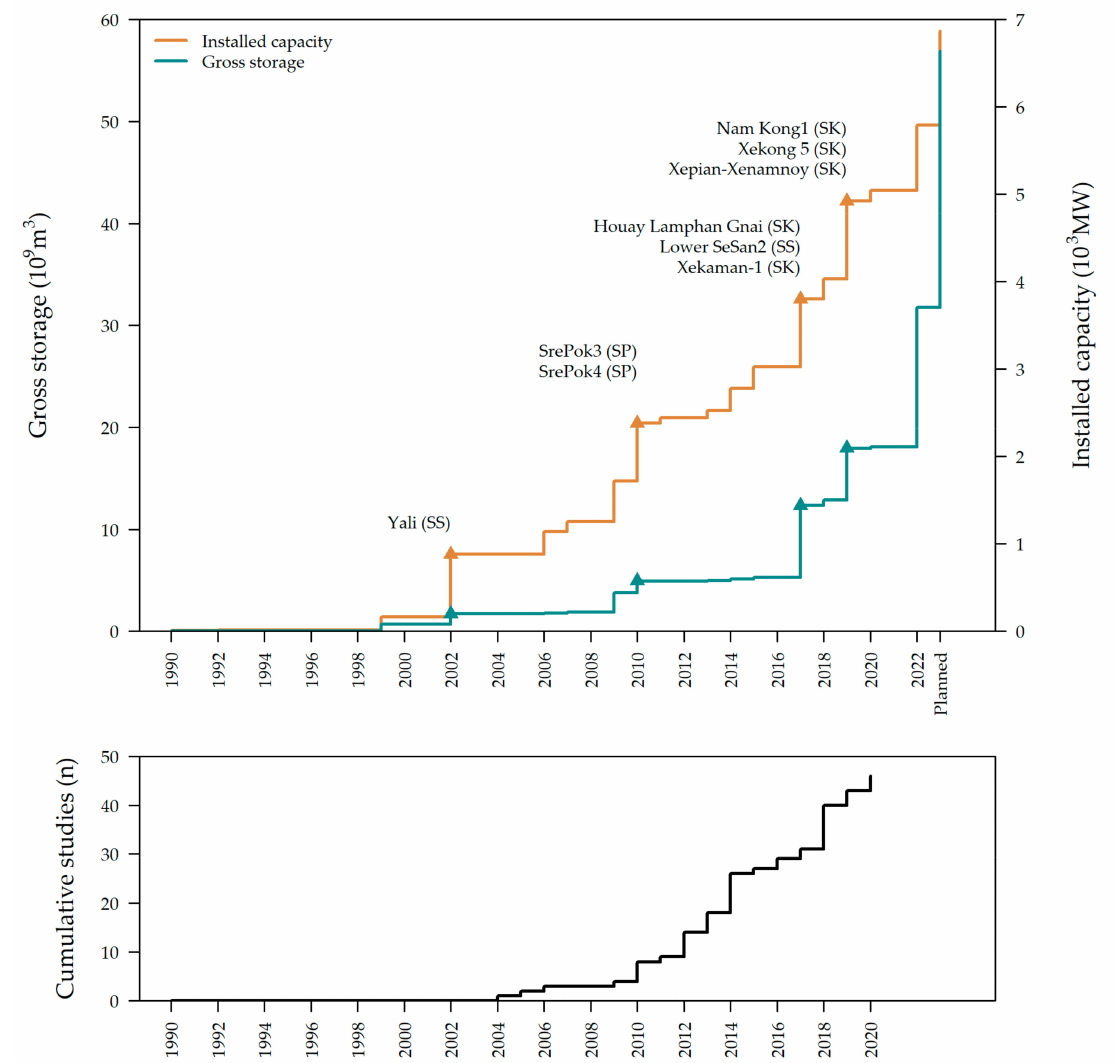
Figure 3. Gross storage and installed capacity of current and planned hydropower projects in the 3S Basin ( top ) with cumulative number of studies through time ( bottom ). SS is Sesan River, SP is Srepok River, and SK is Sekong